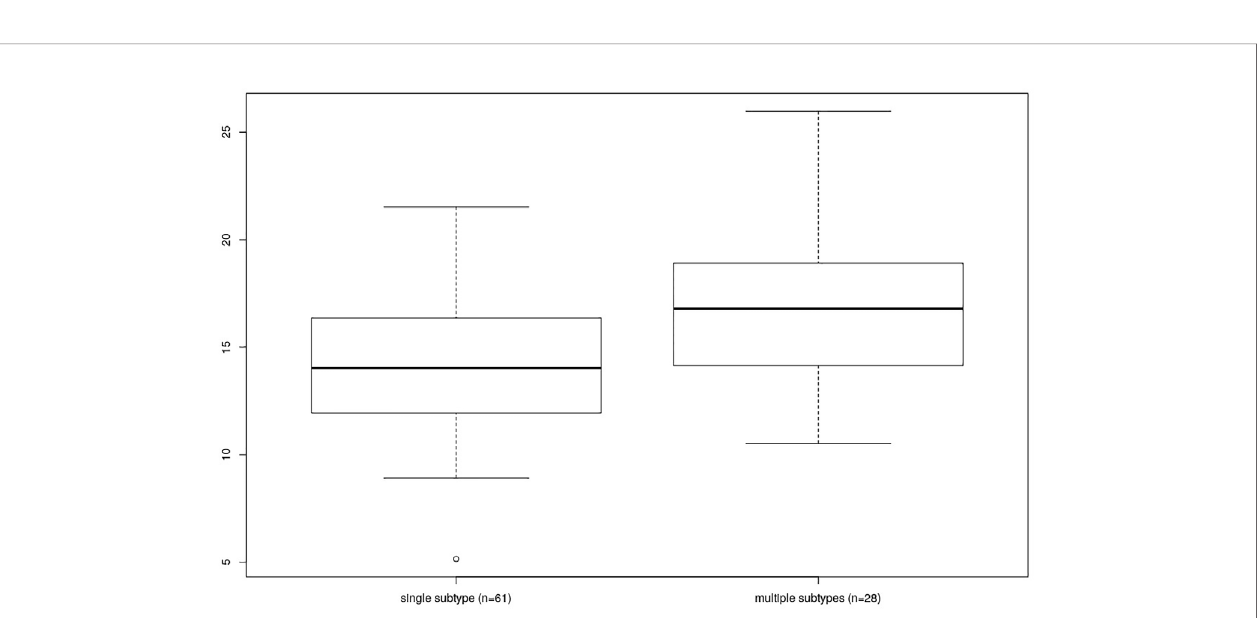
FIGURE 6 | Comparison of Faith ’ s PD between individuals differing by the number of colonizing Blastocystis subtypes (single vs.